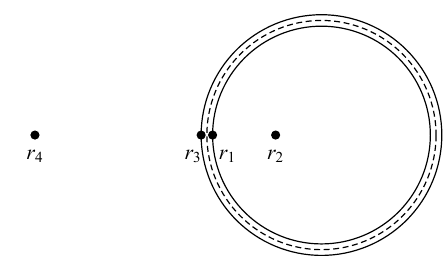
Figure 20. Two copies of Poincare disk with one of them filling outside | z | > 1